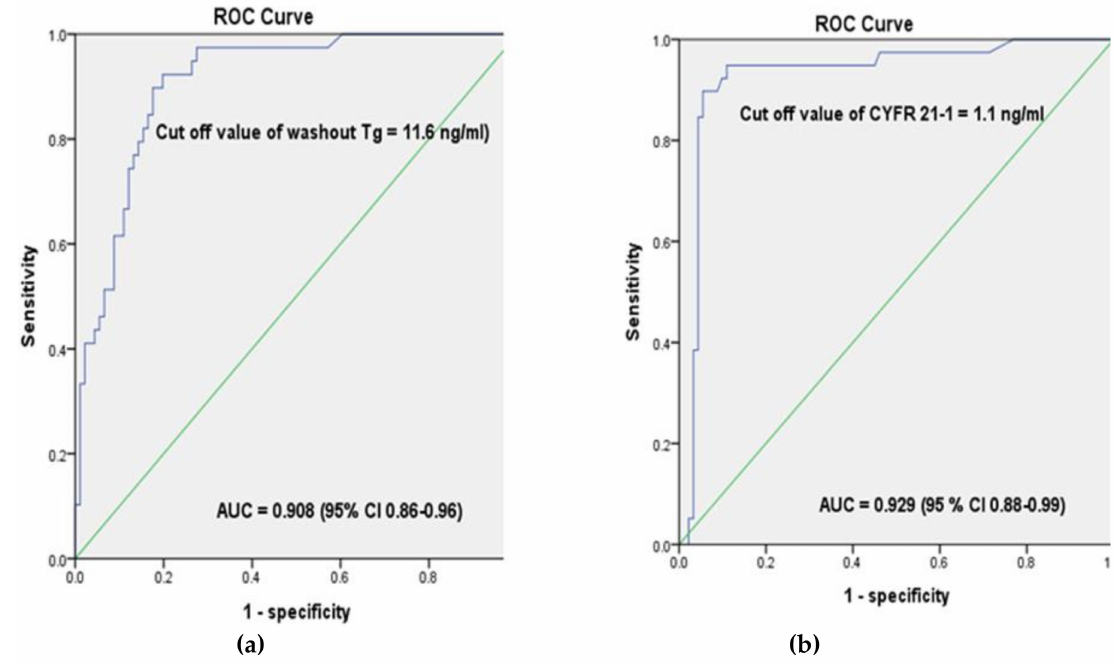
Figure 2. Receiver operating characteristic (ROC) analysis of washout Tg(left) and washout CYFRA 21-1 (right) tested in lymph node fine-needle aspiration ( a ) Metastases were determined using a cuto ff value of 11.6 ng / mL (AUC 0.908, sensitivity 92.3%, and specificity 85.7%) for washout Tg and ( b ) 1.1 ng / mL (AUC 0.929, sensitivity 92.3%, and specificity 91.2%) for washout CYFRA 21-1, respectively.